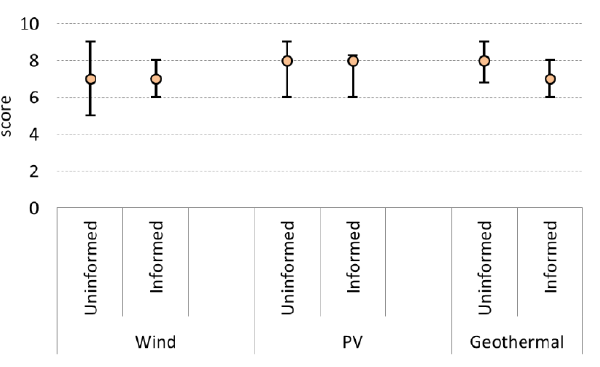
Figure 4. Overall evaluation of wind, PV, and geothermal energy in Kenya: uninformed versus informed (median – round marker, 1 st quartile – lower bar, and 3 rd quartile – upper